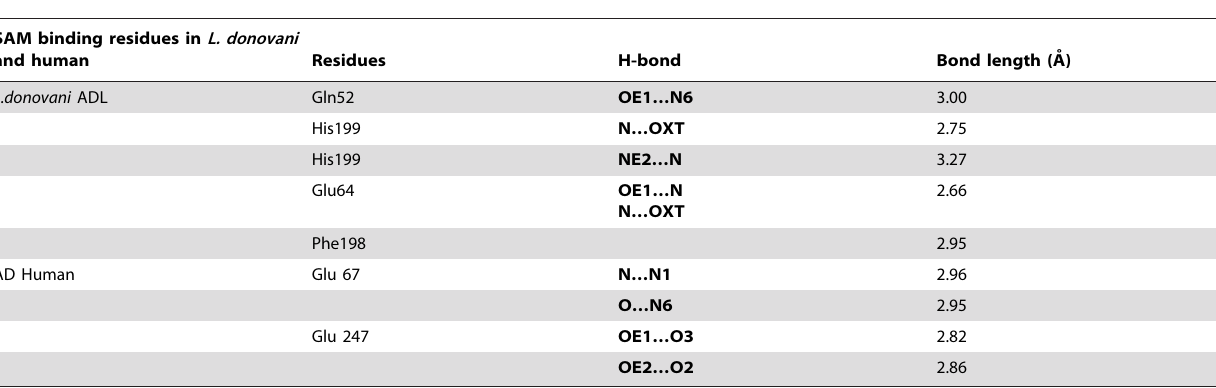
Figure 8. Binding site of SAM and putrescine obtained by molecular docking. (A) Cartoon representation of homology model of L. donovani ADL (cyan) with the docked SAM (cyan), superimposed on SAM-bound crystal structure of human AD (pink) illustrating the differences in relative SAM binding positions. LIGPLOT diagram showing the interactions of the docked SAM with the ADL residues are shown in the bottom panel (B)Cartoon representaton of putrescine (cyan) docked to the ADL homology model. For comparison, the corresponding region of the human AD structure is also shown, with its putrescine (pink). The bottom panel shows LIGPLOT representation of the interaction between putrescine and ADL. doi:10.1371/journal.pone.0065912.g008 Table 2. Showing H-bond interaction of SAM with residues of L. donovani ADL and their comparsion with SAM bound crystal structure of human